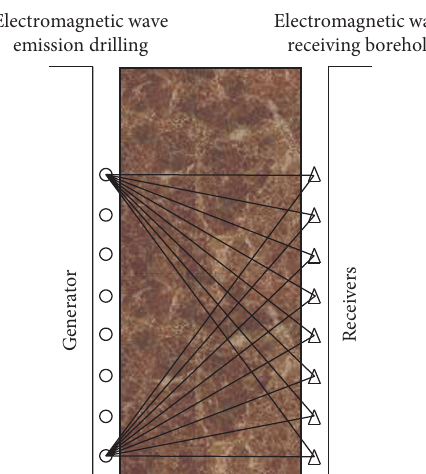
Figure 5: Layout of the cross-hole electromagnetic wave